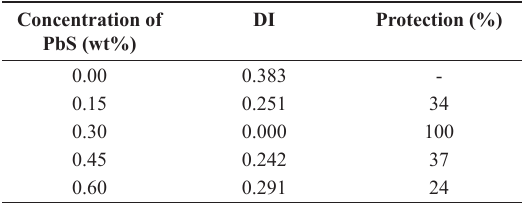
Figure 2. SEM image of PbS-NP. Table 1. Viscosity results for PMMA